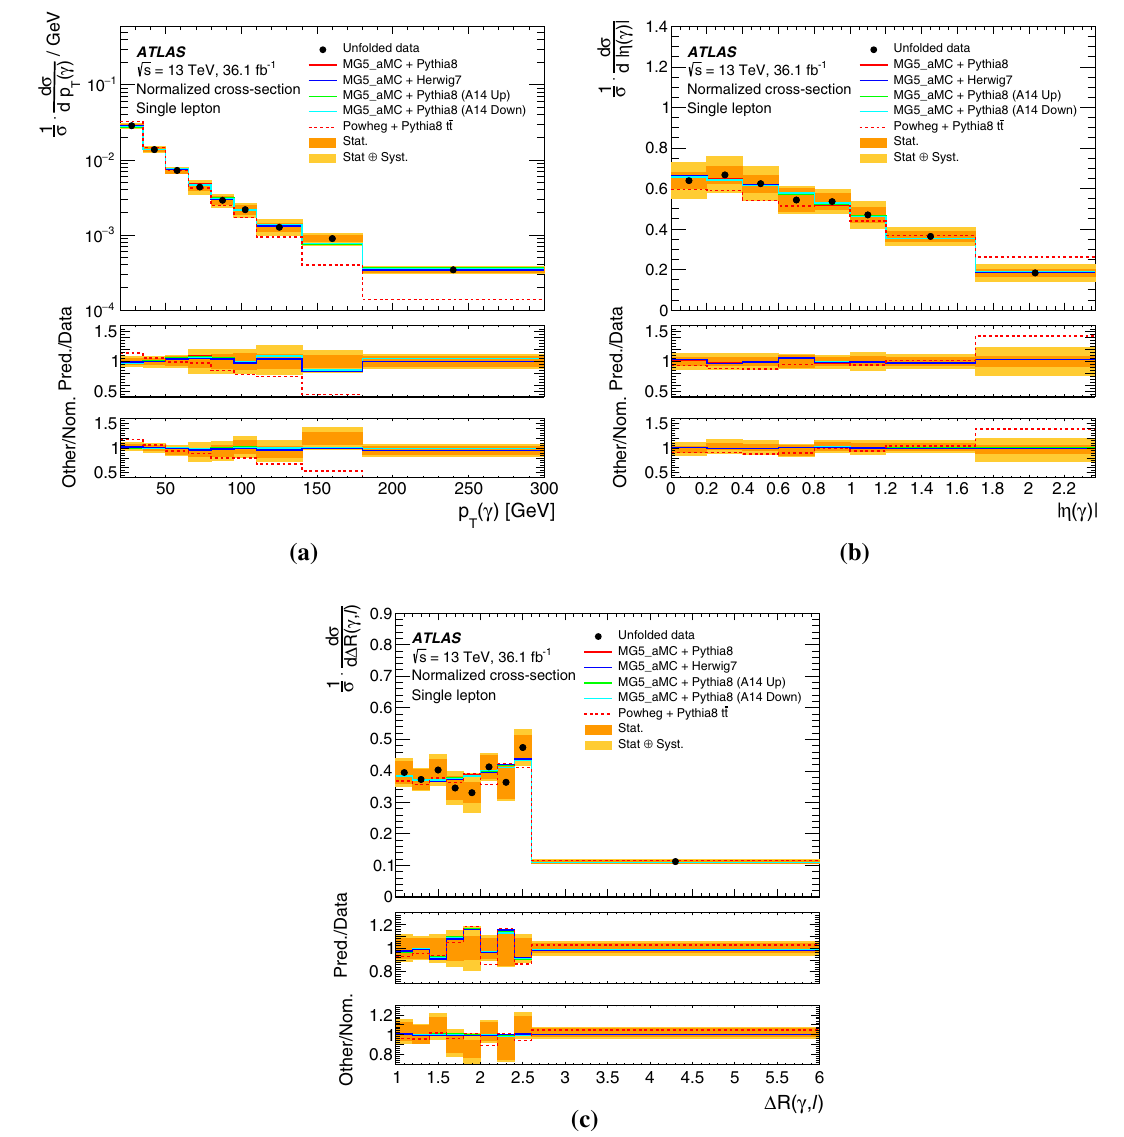
Powheg + Pythia 8 t ¯ t where photon radiation is modelled in the parton shower. The top ratio-panel shows the ratios of all the predictions over data. The bottom ratio-panel shows the ratios of the alternative predic- tions and data over the nominal prediction. Overflows are included in the last